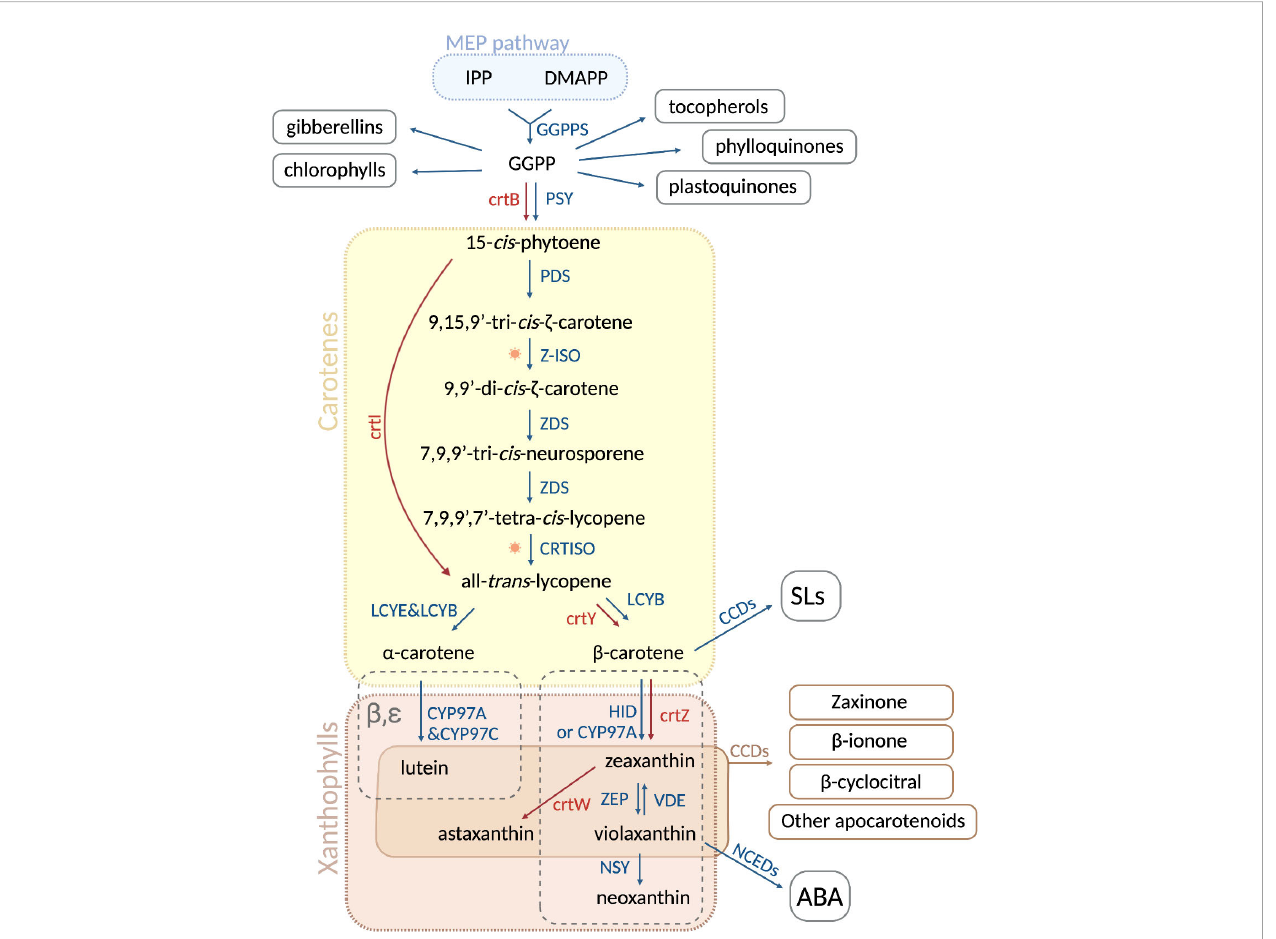
FIGURE 1 Carotenoid biosynthetic pathway in plants and microorganisms. In plastids, the condensation of isopentenyl diphosphate (IPP) and dimethylallyl diphosphate (DMAPP), derived from the MEP pathway, is catalyzed by GGPPS and gives rise to geranylgeranyl pyrophosphate (GGPP). The latter is a precursor of several important plastid isoprenoids, such as tocopherols, phylloquinones, plastoquinones, chlorophylls and gibberellins. Two GGPP molecules are then condensed into 15- cis -phytoene by PHYTOENE SYNTASE (PSY) in plants and by crtB in bacteria and fungi. Sequentially, the enzymes phytoene desaturase (PDS), z -CAROTENE ISOMERASE (Z-ISO), z -CAROTENE DESATURASE (ZDS) and CAROTENOID ISOMERASE (CRTISO) catalyze a series of desaturations and isomerizations, producing all- trans -lycopene from 15- cis -phytoene. In most fungi and bacteria, this conversion is carried out by a single enzyme, PHYTOENE DESATURASE (crtI). At this point, all- trans -lycopene undergoes a cyclization step, which is performed by LYCOPENE ϵ -CYCLASE (LCYE) and LYCOPENE b -CYCLASE (LCYB), leading to a -carotene and b -carotene, respectively. In fungi and non-photosynthetic bacteria, b - carotene is formed by crtY. In the a branch, the cytochrome P450 enzymes CYP97A and CYP97C convert a -carotene into lutein, while the non-heme diiron oxidase (HYD)/CYP97A in the b -branch transforms b -carotene into zeaxanthin. In microorganisms, the enzyme crtZ produces zeaxanthin, which can be further converted by crtW into astaxanthin. In plants, ZEAXANTHIN EPOXIDASE (ZEP) is responsible of the conversion of zeaxanthin into violaxanthin, which can be reversed into zeaxanthin through the action of VIOLAXANTHIN DE-EPOXIDASE (VDE). Violaxanthin is then transformed into neoxanthin by NEOXANTHIN SYNTHASE (NSY) as a last step of the pathway. Oxidative cleavage of carotenoids gives rise to apocarotenoids. The cleavage of b -carotene performed by carotenoid cleavage dioxygenases (CCDs) generates carlactone (not shown) the precursor of strigolactones (SLs), whereas 9- cis -violaxanthin is cleaved into the abscisic acid (ABA) precursor, xanthoxin (not shown), by nine- cis -epoxy-carotenoid dioxygenases (NCEDs). Plant and microbial enzymes are colored in blue and red, resperctively. Sun image represents photoisomerization. Figure was designed in